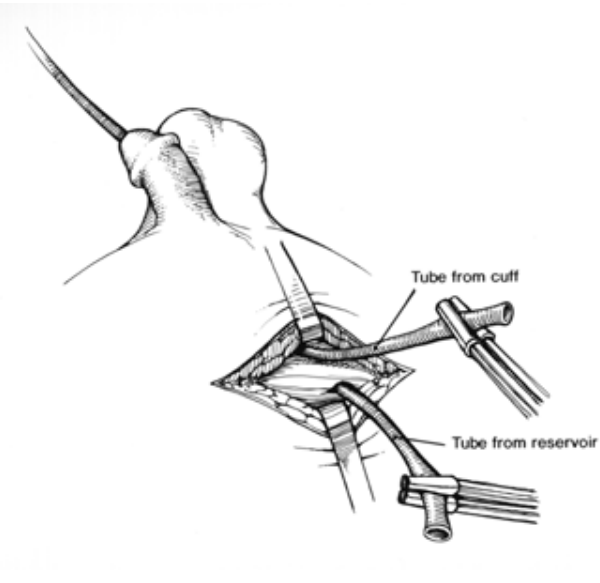
FIGURE 7. Positioning of cuff and reservoir tubing after placement of the balloon